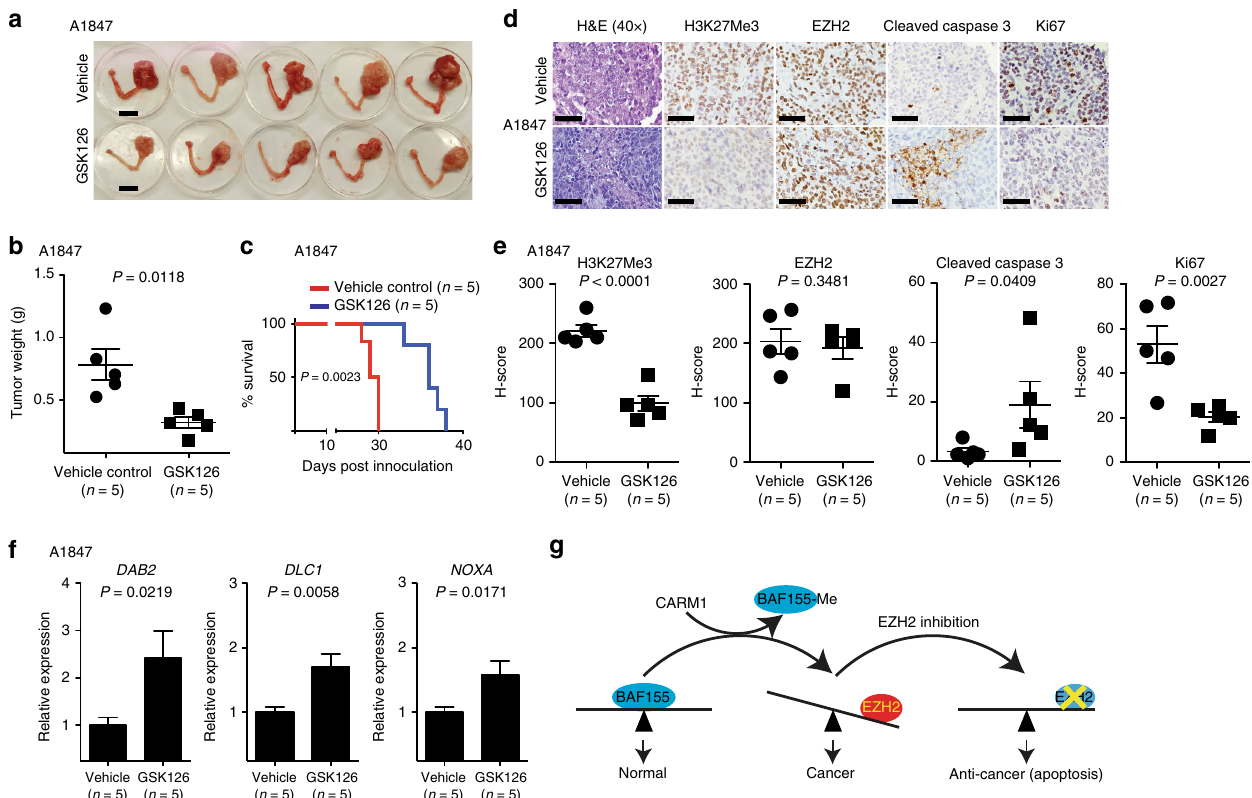
Fig. 6 EZH2 inhibition suppressed the growth of CARM1-expressing tumors in vivo and improved the survival of mice bearing CARM1-expressing tumors. a CARM1-high A1847 ovarian cancer cells were unilaterally injected into the ovarian bursa sac of immunocompromised mice ( n = 5/group). Tumors were allowed to establish for 1 week before the mice were randomized into two different treatment groups. Mice were treated with vehicle control or GSK126 (50 mg/kg daily) for an additional 3 weeks. At the end of treatment, the mice were euthanized. Shown are images of reproductive tracts with tumors from control or GSK126-treated mice. Bar = 1 cm. b Tumor weight was measured as a surrogate for tumor burden from the control and GSK126-treated mice. c After stopping the treatment, the mice from the indicated groups were followed for survival. Shown is the Kaplan – Meier survival curve for GSK126 or vehicle-treated mice. P -value was calculated by log-rank test. d The serial sections of tumors dissected from the indicated treatment groups were subjected to immunohistochemical staining for H3K27Me3, EZH2, cleaved caspase 3, and Ki67. Scale bar = 50 μ m. e Histological score (H-score) of the indicated proteins was calculated for three separate fi elds from fi ve tumors from fi ve individual mice from each of the indicated groups. f Expression of the indicated EZH2/BAF155 target genes was determined by qRT-PCR in the tumors dissected from the indicated treatment groups. g CARM1 regulates the antagonism between SWI/SNF and PRC2 through methylating BAF155. EZH2 inhibition reactivates EZH2/BAF155 target tumor suppressive genes to promote apoptosis, inhibit proliferation, and suppress tumor growth. Error bars represent SEM. P -values are from two-tailed t